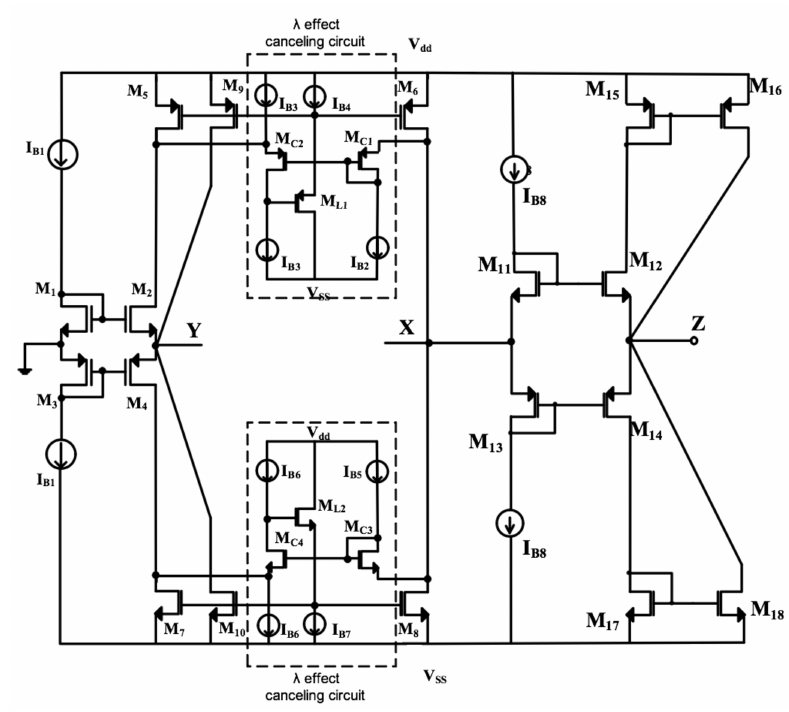
Figure 6. A complete schematic of the proposed class AB high drive